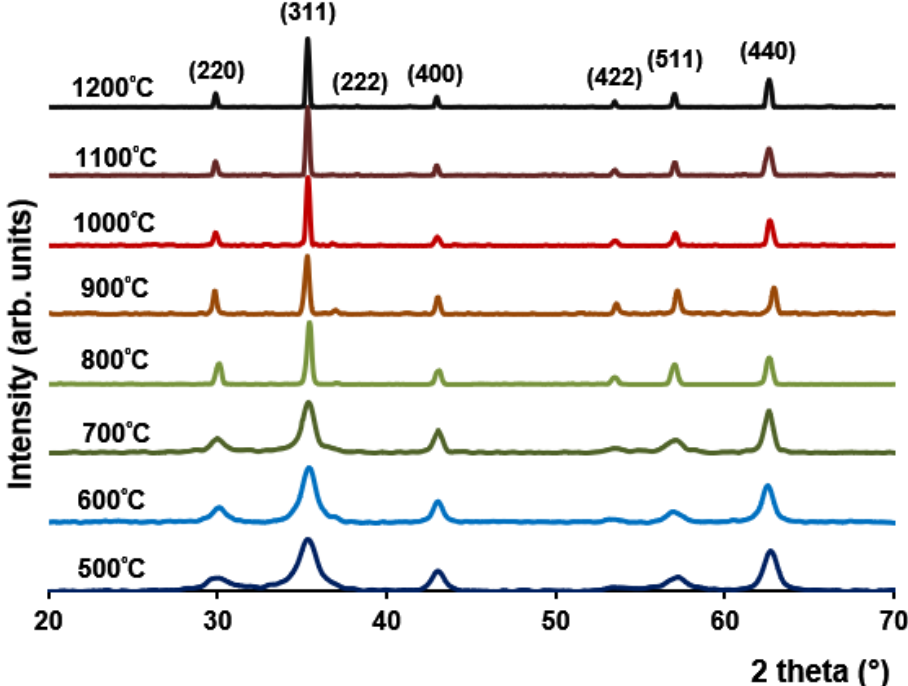
Figure 3. X-raydiffractionresultsfortheMgFe 2 O 4 Figure 3. X-ray diffraction results for the MgFe 2 O 4 samples following calcination at the various tem- peratures.